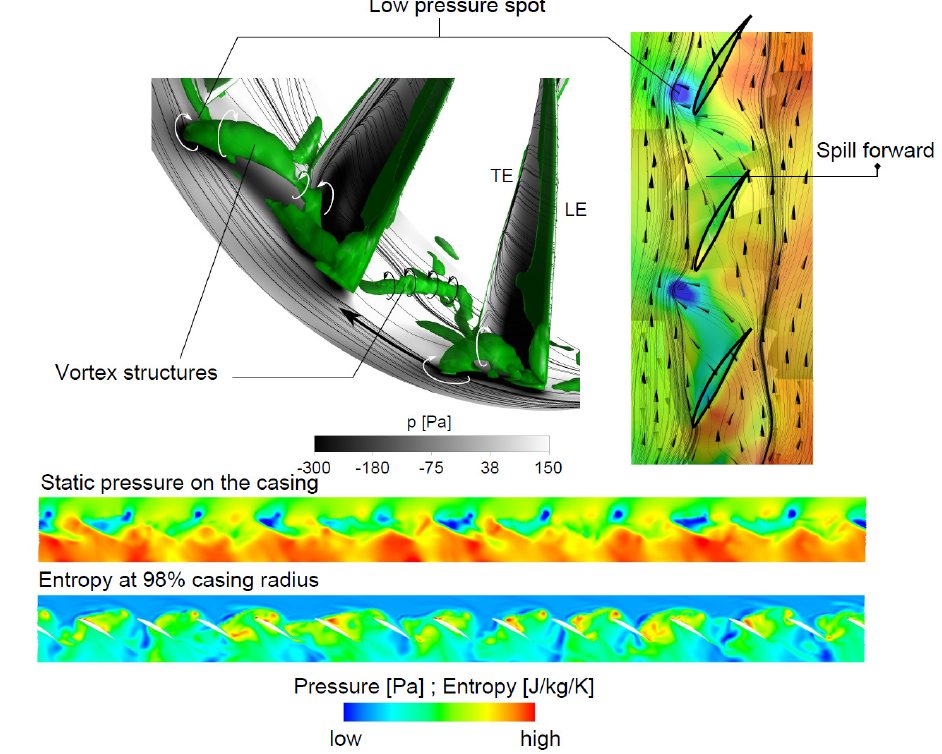
Figure 10. Flow mechanism of Rotating Instability